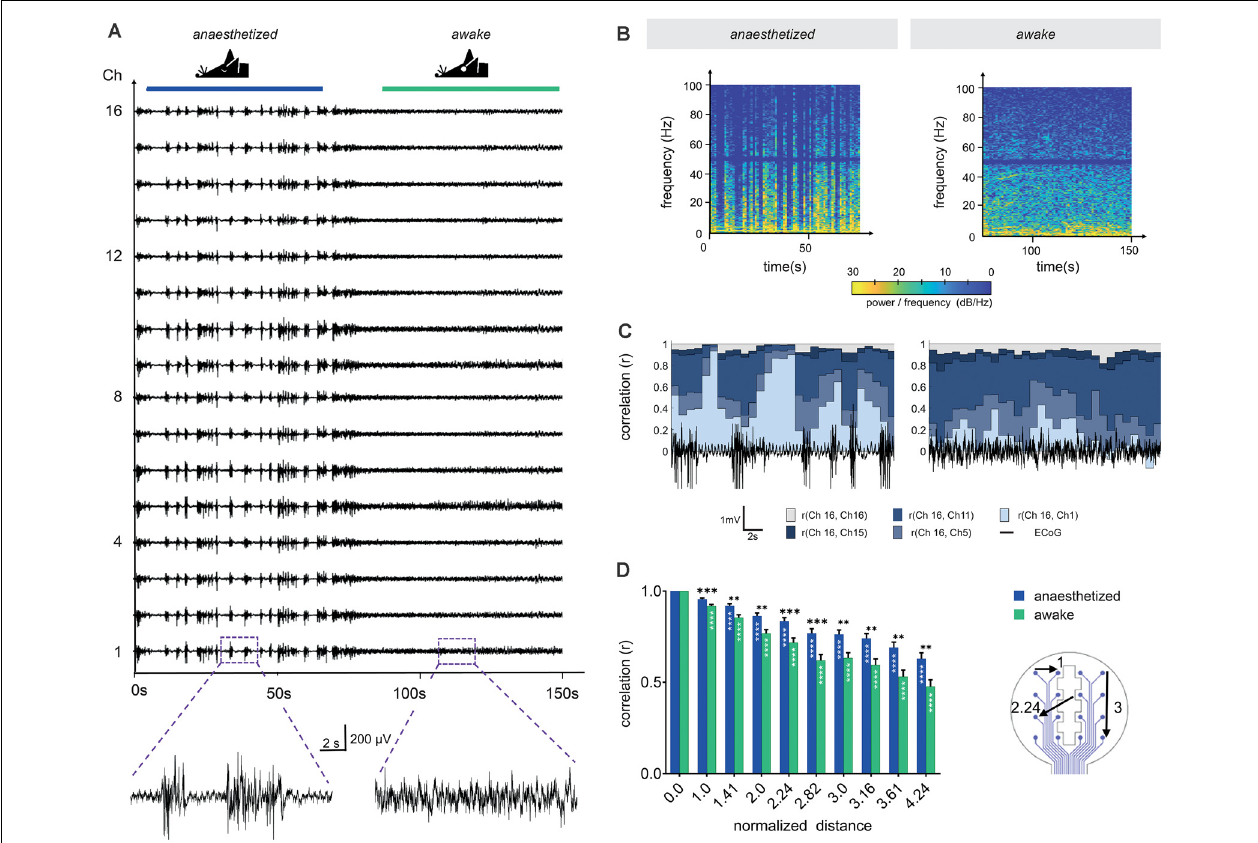
FIGURE 5 | Channel correlation analysis detects differences in brain activity between the anesthetized and the awake state. (A) Sixteen-channel ECoG recording displays the pattern change from the anesthetized state (1.5% isoflurane) to the awake state. (B) Spectrograms in anesthetized and awake conditions represent the power spectral densities of individual frequencies over time. In the anesthetized animal, frequencies below 10 Hz display the highest power with intermittent synchronous activity bursts, raising the power of frequencies up to approximately 100 Hz. Similarly, frequencies below 10 Hz dominated in the awake state, however, higher frequencies were continuously represented. We applied a Notch filter at 50 Hz, represented by the dark band in this frequency range. (C) Channel similarity revealed by correlation analysis between the different electrode sites (channels) and under anesthetized and awake conditions. The similarity of the most distant recording sites [r (Ch16, Ch1)] increased substantially after synchronous burst activity under anesthesia. (D) Channel similarity (correlation) decreases with increasing distance between electrode sites (channels). In awake animals, the channel correlation is systematically lower than under anesthesia. Statistics: Two-Way ANOVA followed by Dunnett’s multiple comparisons test for different distances compared to distance 0.0 of the respective anesthesia group (white stars inside bars) and Fisher’s LSD for comparisons between awake and anesthetized (black stars above). Data are shown as mean ± SEM, ** p < 0.01, ∗∗∗ p < 0.001, ∗∗∗∗ p < 0.0001, N (anesthetized) = 21 and N (awake) = 23 measurements per distance